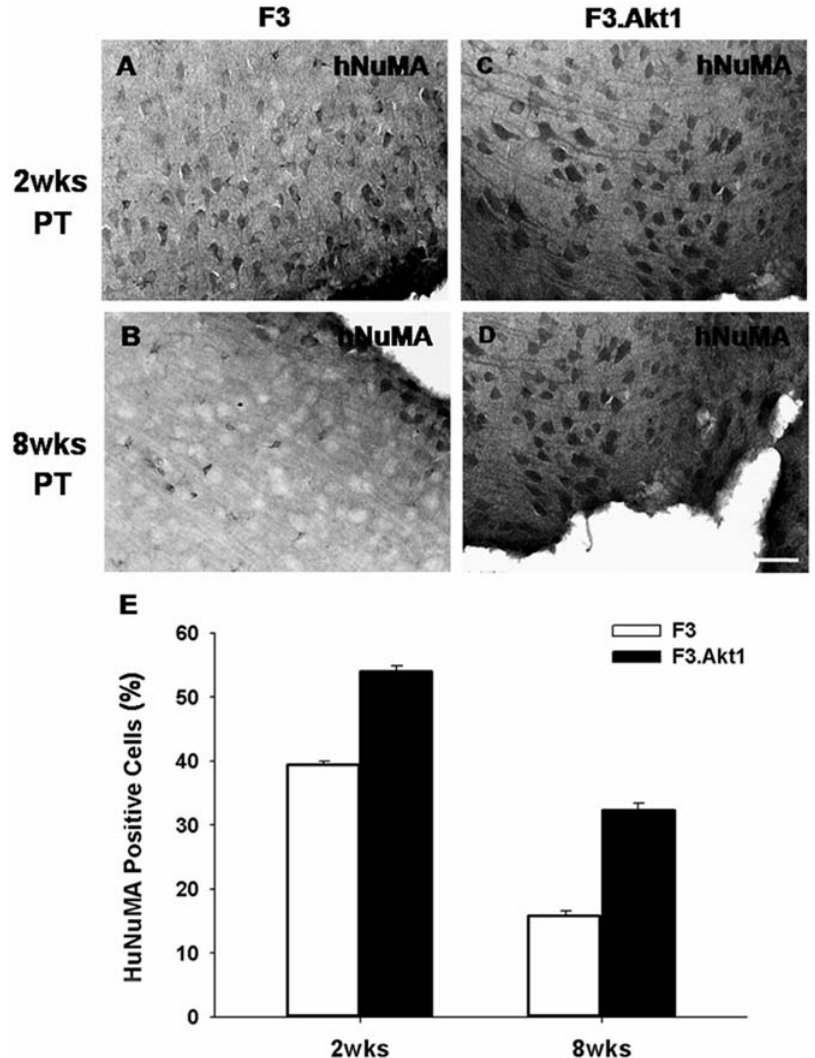
Figure 5. At 2 weeks post-transplantation (PT) in the hemorrhage core border areas, difference in number of human nuclear matrix antigen (hNuMA)-positive cells between ICH-F3 control group (A) and ICH-F3.Akt1 group (C) is not apparent, but at 8 weeks PT number of hNuMA-positive cells is much higher in F3.Akt1-ICH group (D) as compared to control F3-ICH group (B). Bar indicates 100 m m. E: Percentage of hNuMA-positive cells found in hemorrhage core border area is higher in ICH-F3.Akt1 group as compared to ICH-F3 group at both 2 and 8 weeks